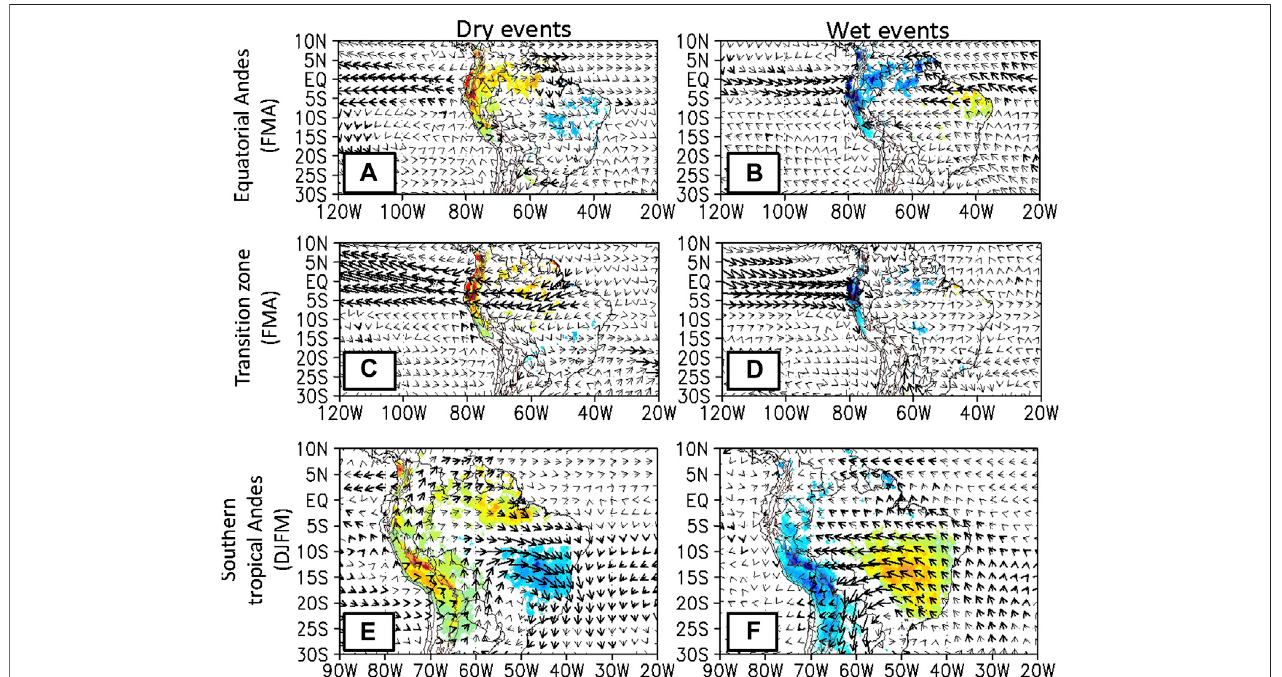
FIGURE 10 | (A) Composite for CHIRPS precipitation (shaded; p < 0.05 according to a Cramér test) and vertically integrated water vapor fl ux (vectors) using a Kramer test with a p-value of 0.05. (B) Similar to (A) but for wet events in the northern Peruvian Andes from February to april. (C,D) Similar to (A,B) , respectively, but for dry and wet events in the transition zone from February to april. (E) Anomalies considering monthly dry events from February to april in the equatorial Andes. Only signi fi cantprecipitationanomaliesareshownandboldvectorsrepresentsigni fi cantmeridionalorzonalverticallyintegratedwatervapor fl uxanomalies. (F) similarto (A,B) , respectively, but for dry and wet events in the south tropical Andes from December to March. Adapted from Segura et al. (2019). © Climate Dynamics. Reprinted by permission from Springer Nature.